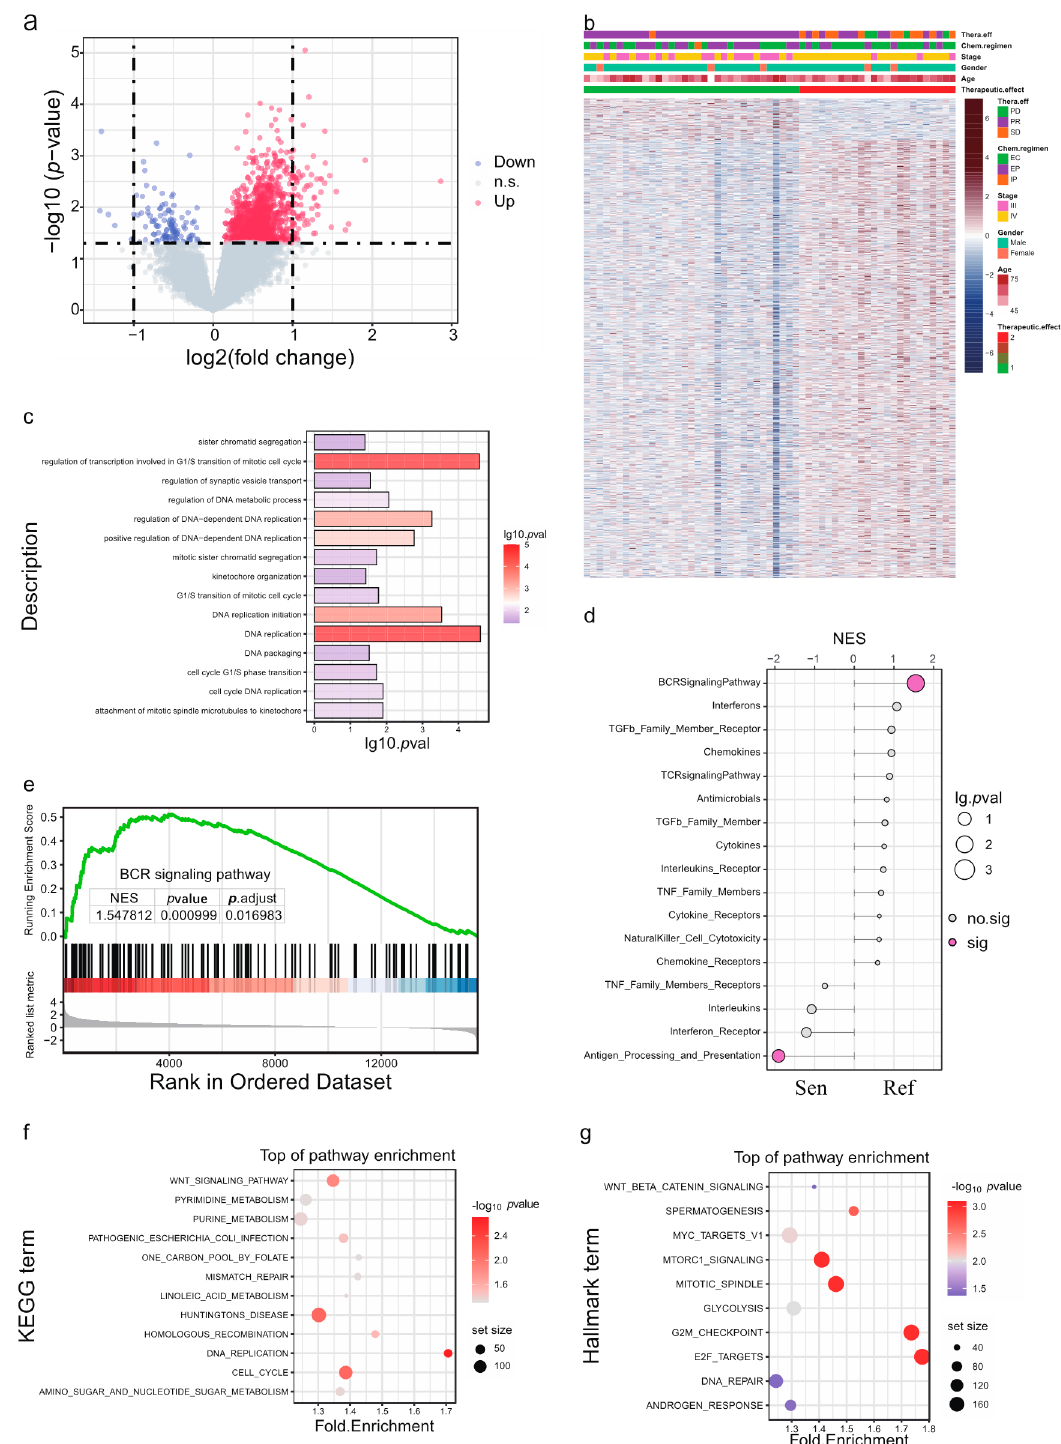
Figure 2. ExLR-seq analysis of patients with SCLC. ( a ) Volcano plot and ( b ) hierarchical clustering of differential expressed exLRs between chemo-sensitive and chemo-refractory groups. ( c ) GO analysis of the differentially expressed exLRs. ( d ) Enrichment score comparisons for immune-related pathways. ( e ) BCR signaling pathway enriched in the chemo-refractory group by gene set. ( f ) KEGG pathway analysis. ( g ) Enrichment score comparisons for hallmark analysis. GO: gene ontology; KEGG: Kyoto Encyclopedia of Genes and Genomes.